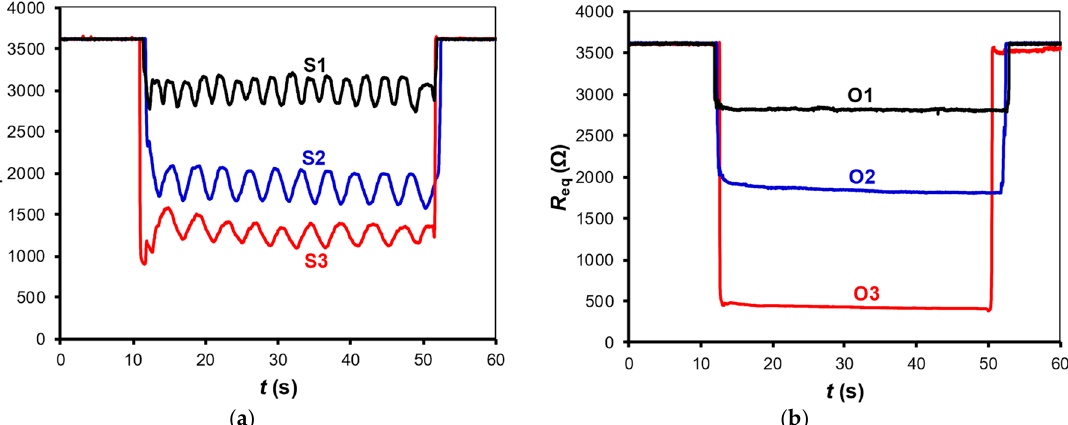
Figure 3. Experimental resistance variations monitored by the DIC shown in Figure 2 when over the chair we had: ( a ) subjects of different weight and age; ( b ) objects of different